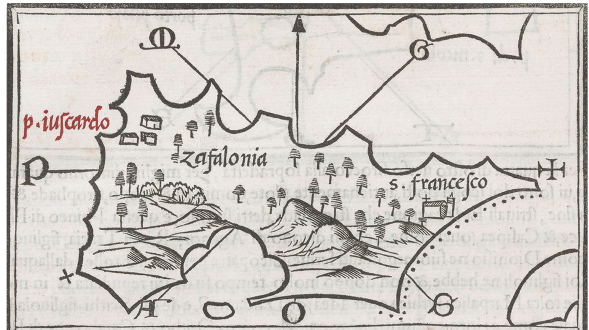
Figure 7 . B. Bordone, Isolario di Benedetto Bordone nel qual